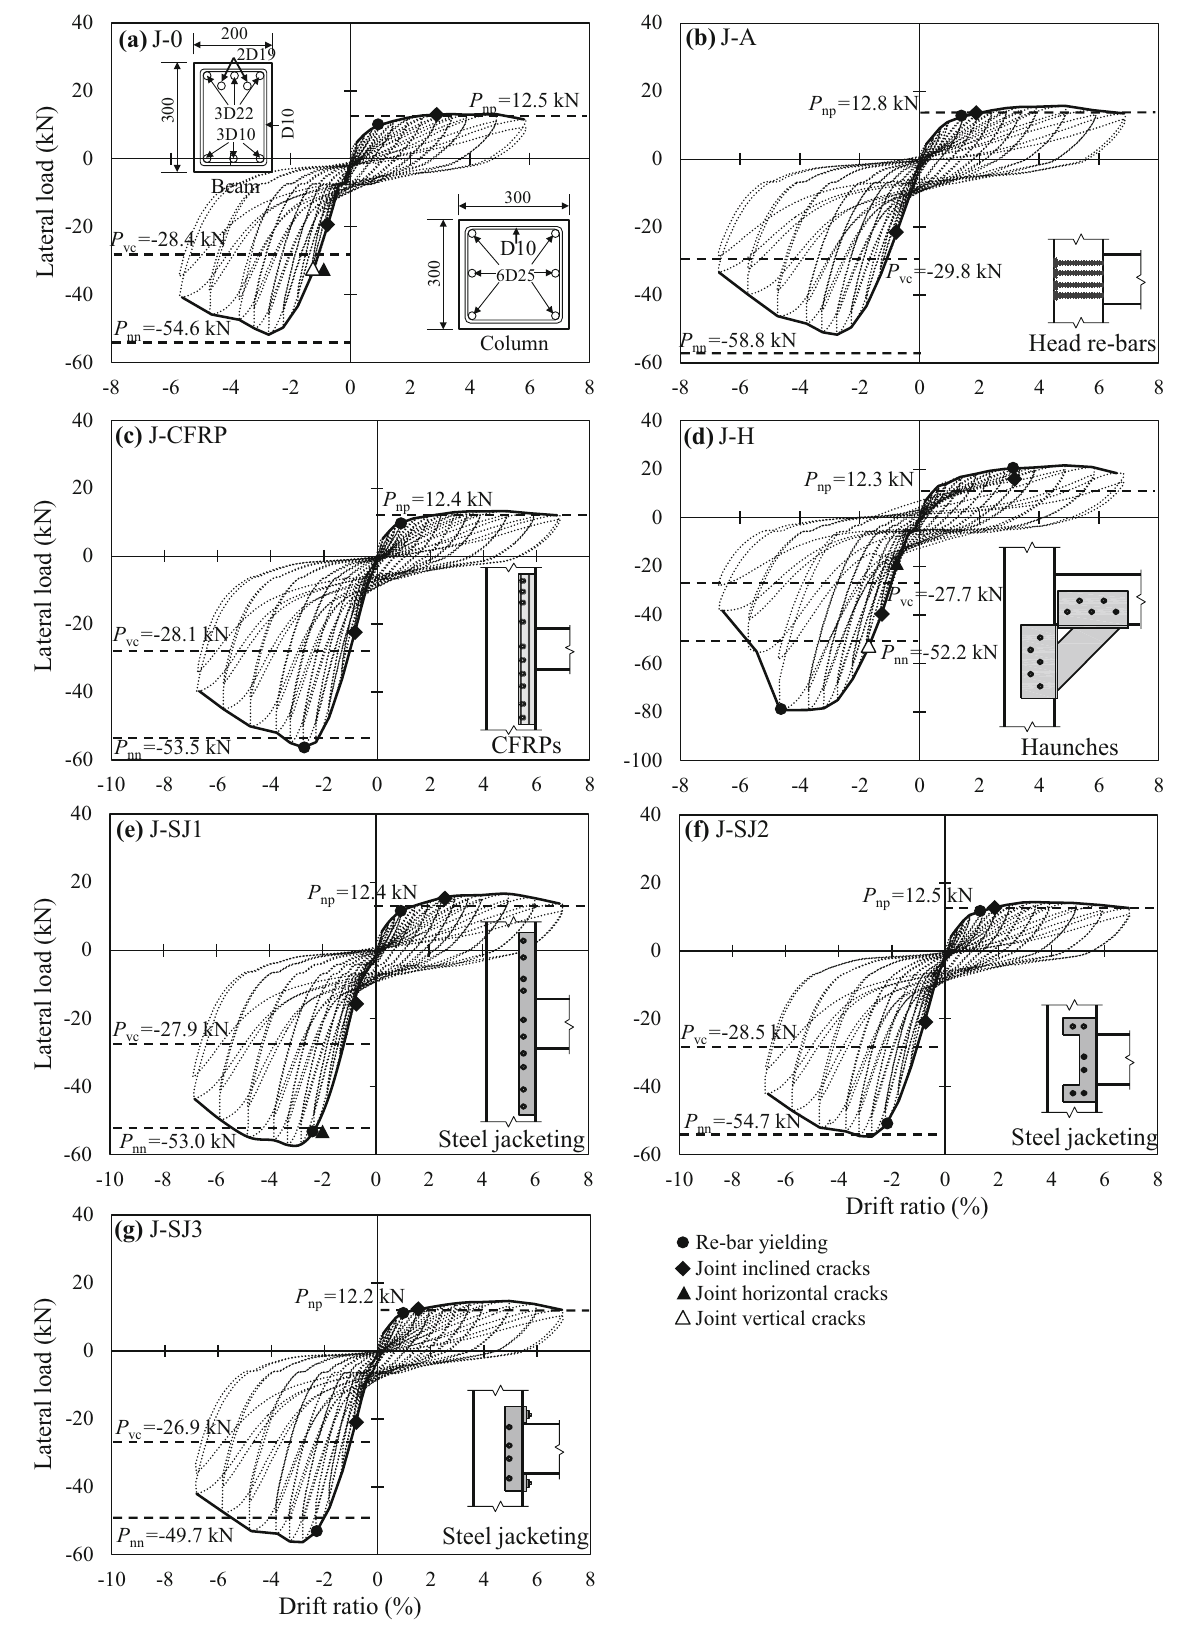
Fig. 15 Load–drift hysteretic relationships of test